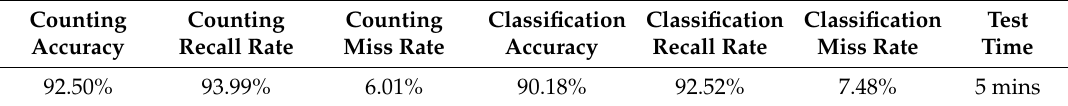
Table 5. Classification and fine counting performance.